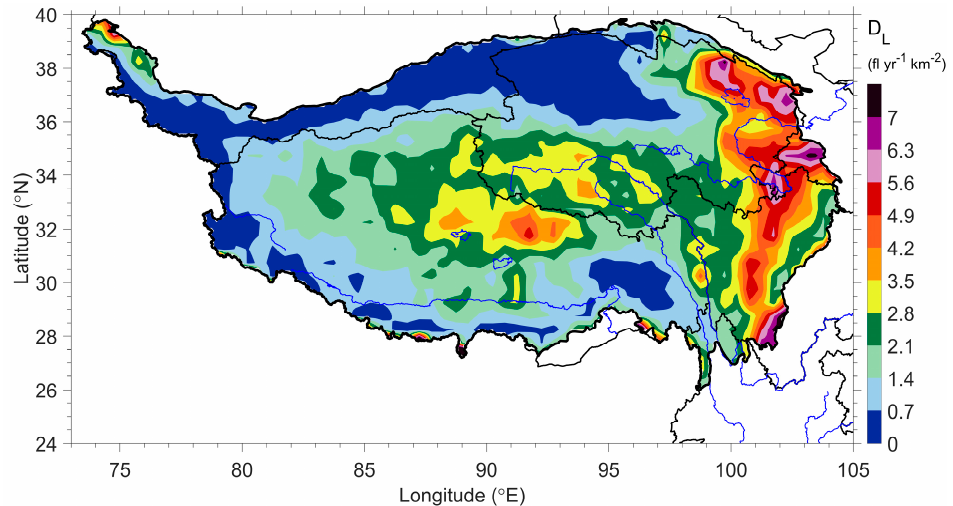
Figure 13. Lightning distribution over the QTP observed by the OTD and LIS based on the 0.5° HRFC dataset.